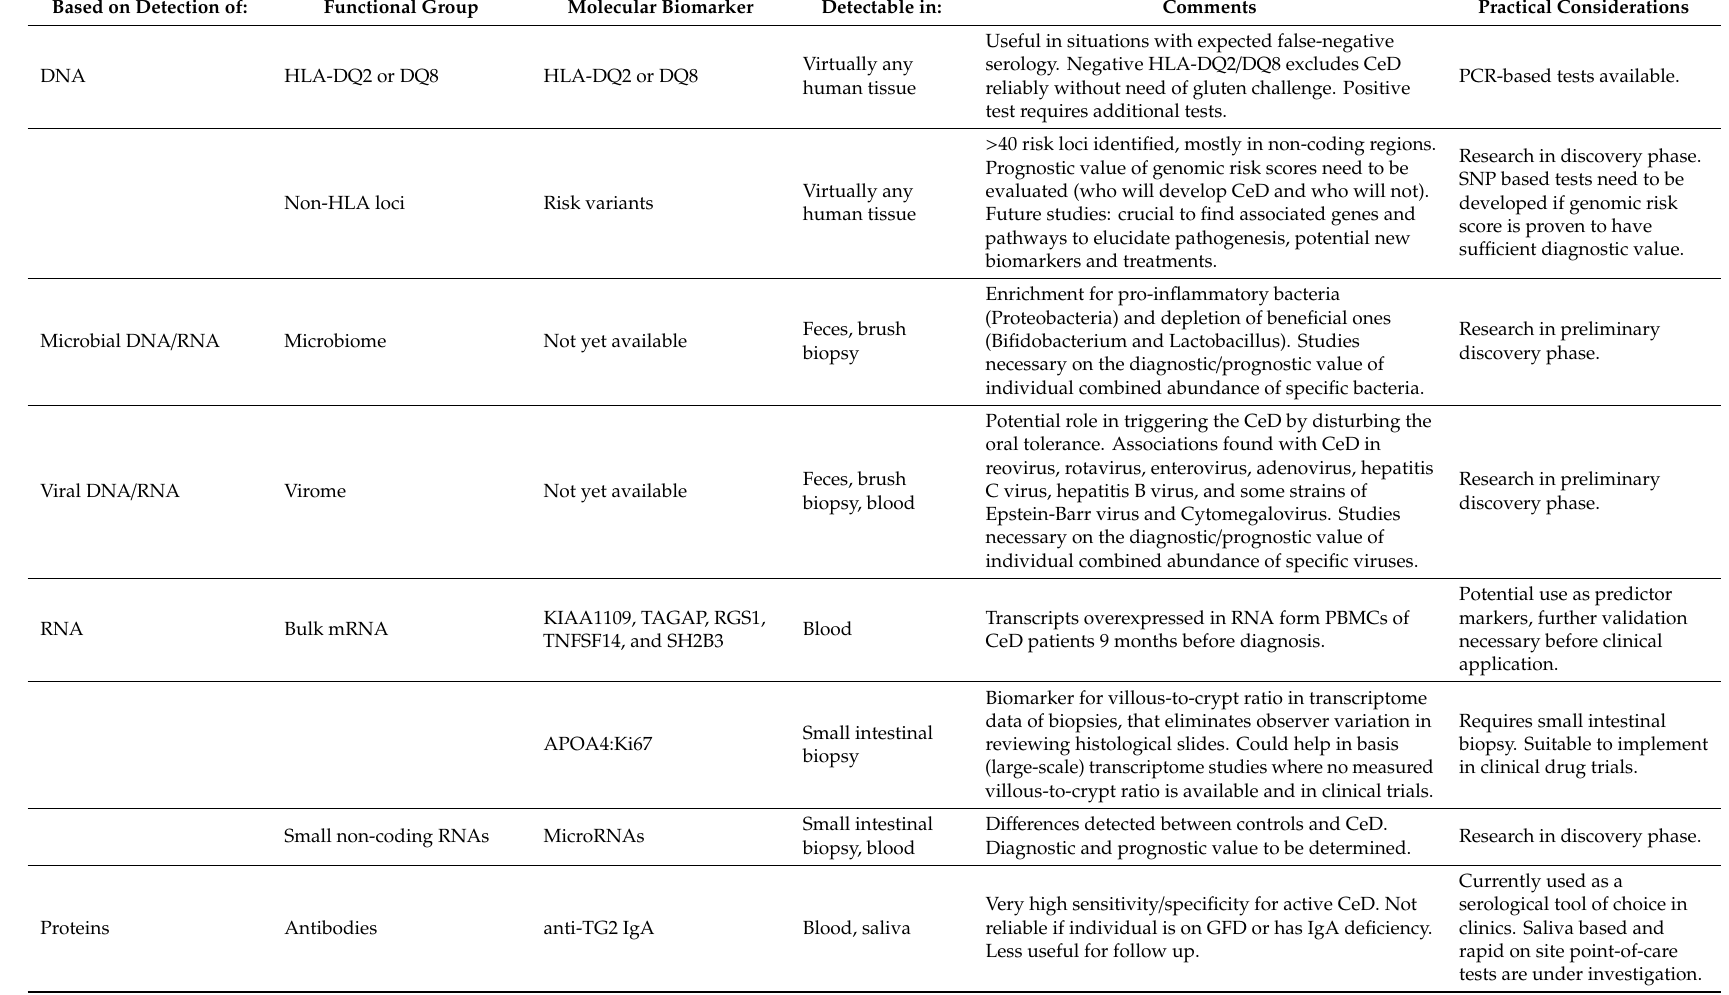
Table 1. Overview of current and future biomarkers for celiac disease